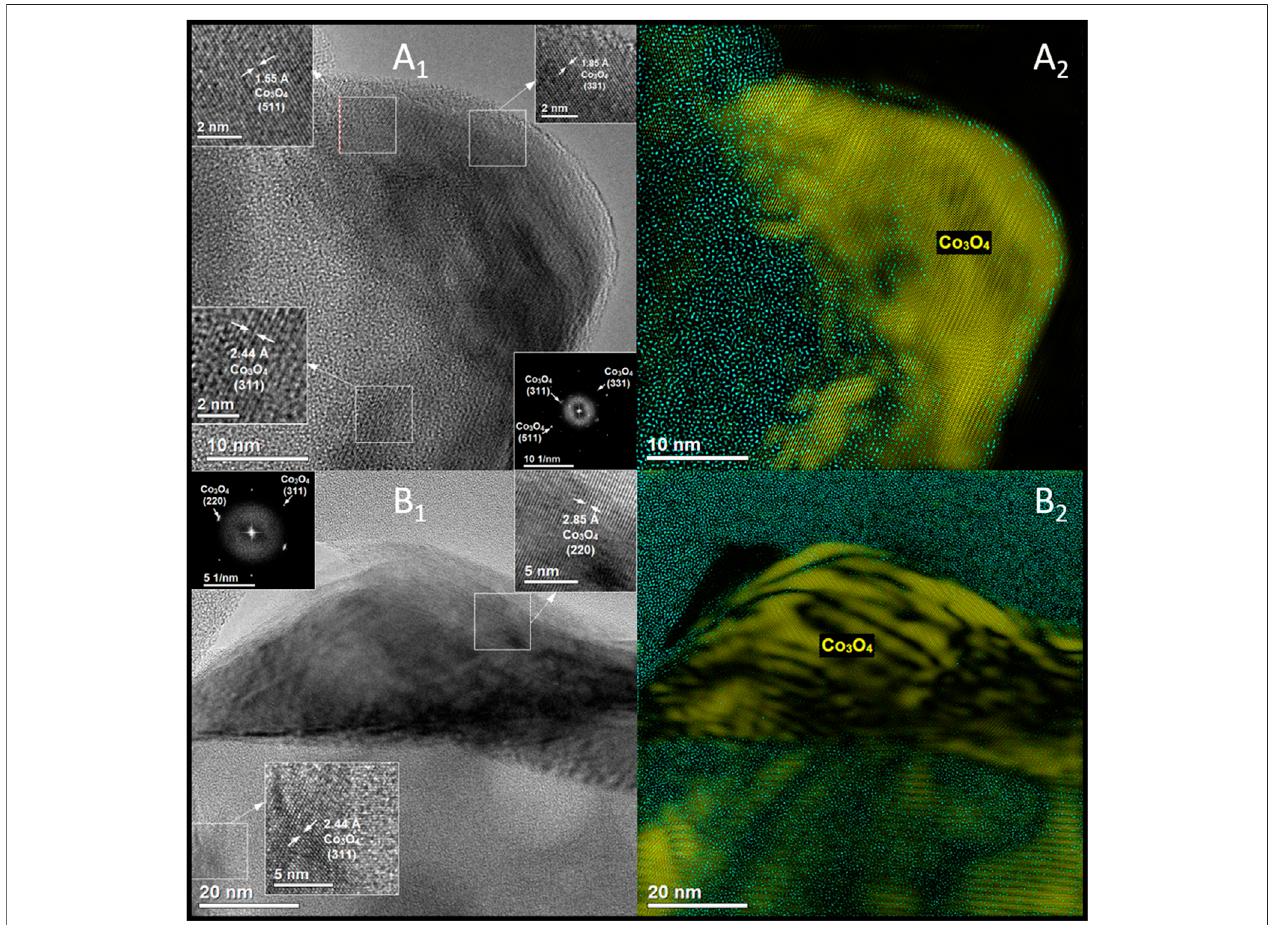
FIGURE 3 | HRTEM images together with FFT and phase identi fi cation of the CoUSY (A 1 ,A 2 ) and CoZSM-5 (B 1 ,B 2 ) samples.